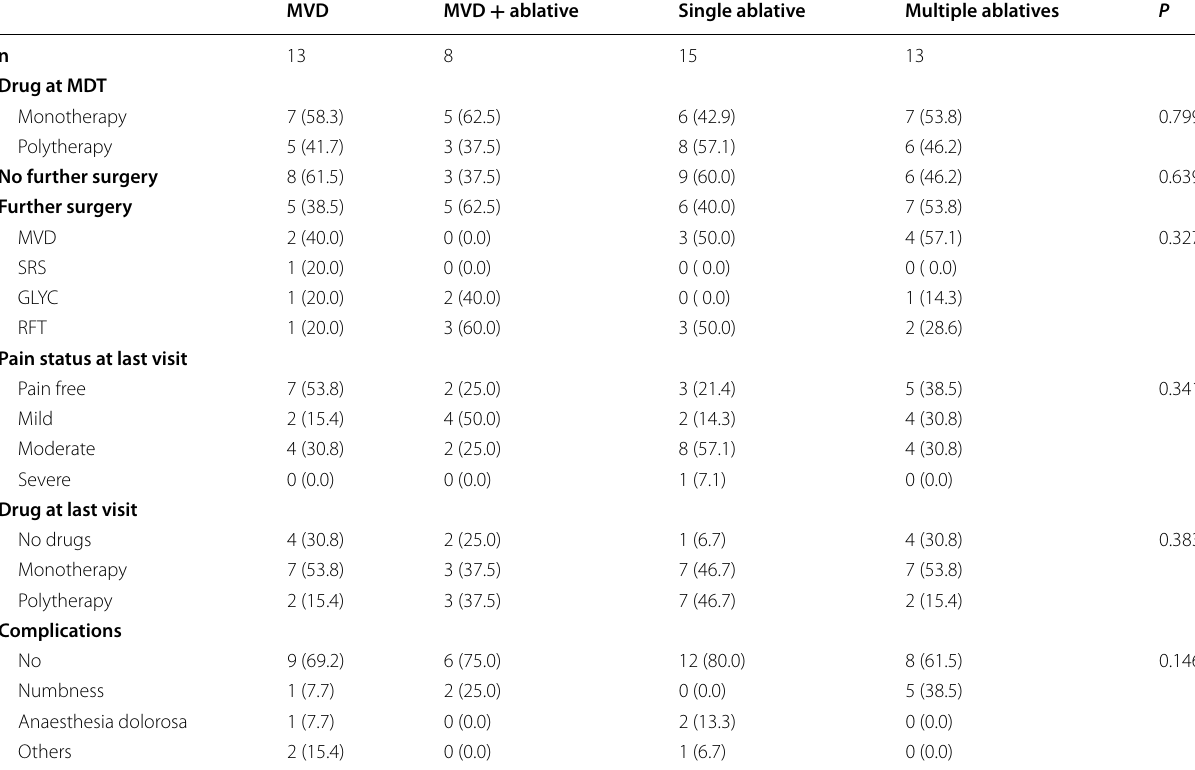
Missing pain status for one patient MVD Microvascular decompression, SRS Stereotactic radiosurgery, GLYC Glycerol rhizotomy, RFT Radiofrequency